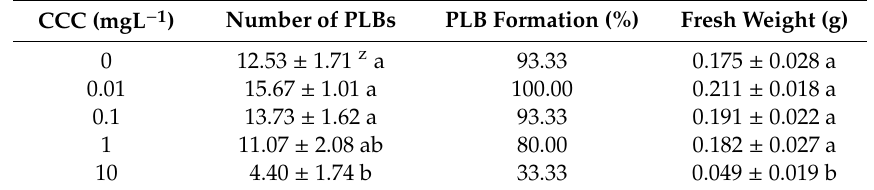
Table 3. Role of CCC concentrations forthe in vitro PLB production of Phalaenopsis ‘Fmk02010’.